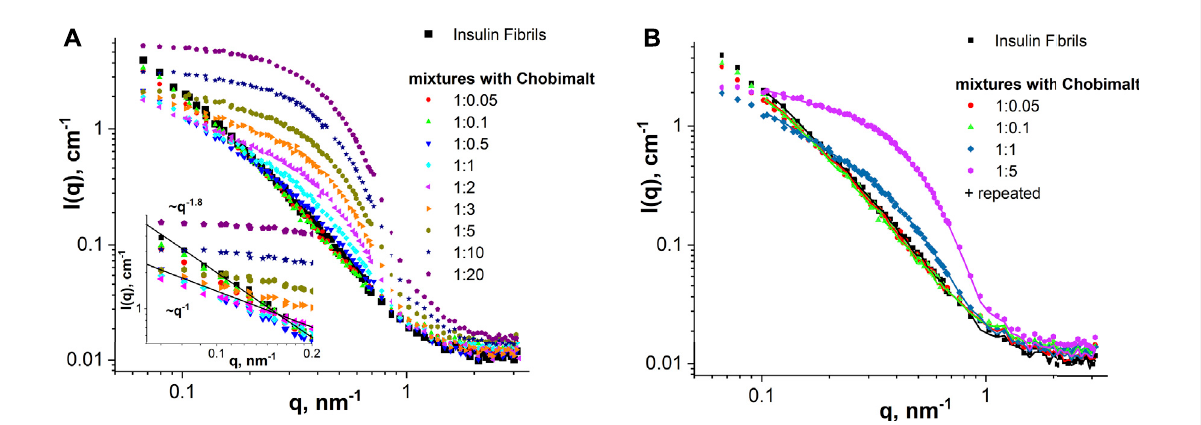
FIGURE 6 SANS analysis. (A) SANS curves of insulin fi brils formed alone and in the presence of different concentrations of Chobimalt. The inset graph represents the initial part of SANS curves for q below 0.2 nm -1 together with power-law lines I(q)~q -1 and I(q)~q -1.8 . (B) SANS examination of the stability of insulin fi brils alone and formed in the presence of Chobimalt over time (symbols — initial samples and solid lines — samples measured after 1-week storage).